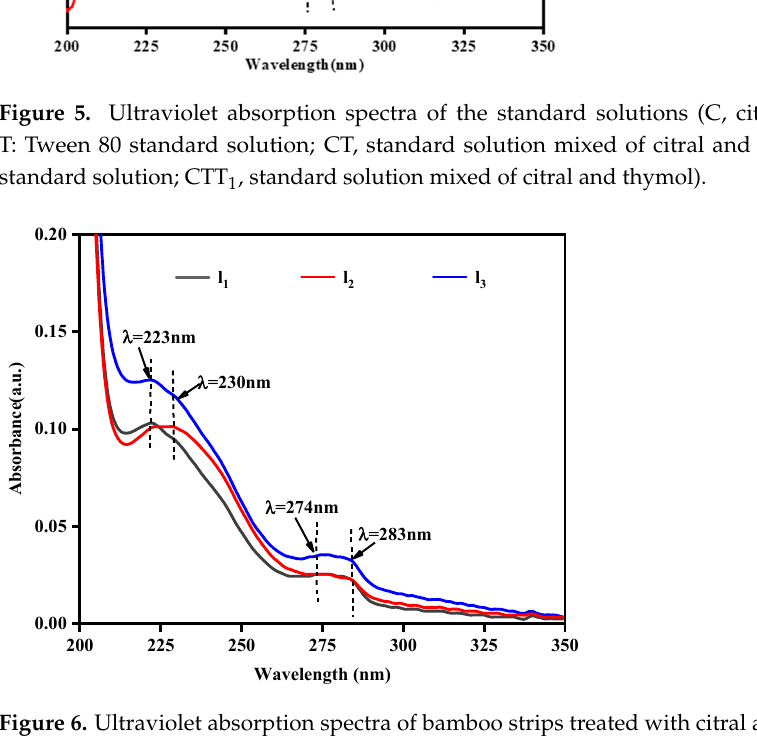
Figure 6. Ultraviolet absorption spectra of bamboo strips treated with citral and thymol compound (l 1 , supernatant of length 0–1 mm; l 2 , supernatant of length 1–2 mm; l 3 , supernatant of length 2–3 mm).